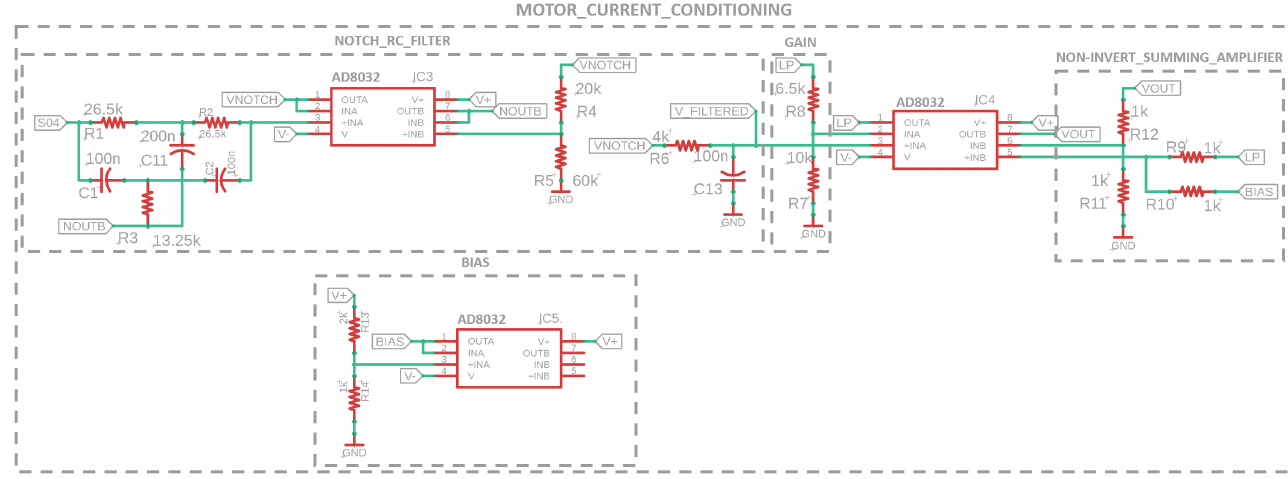
Figure 10. Motor current feedback circuit is made up of a two-stage filter design, a biasing circuit, and a summing